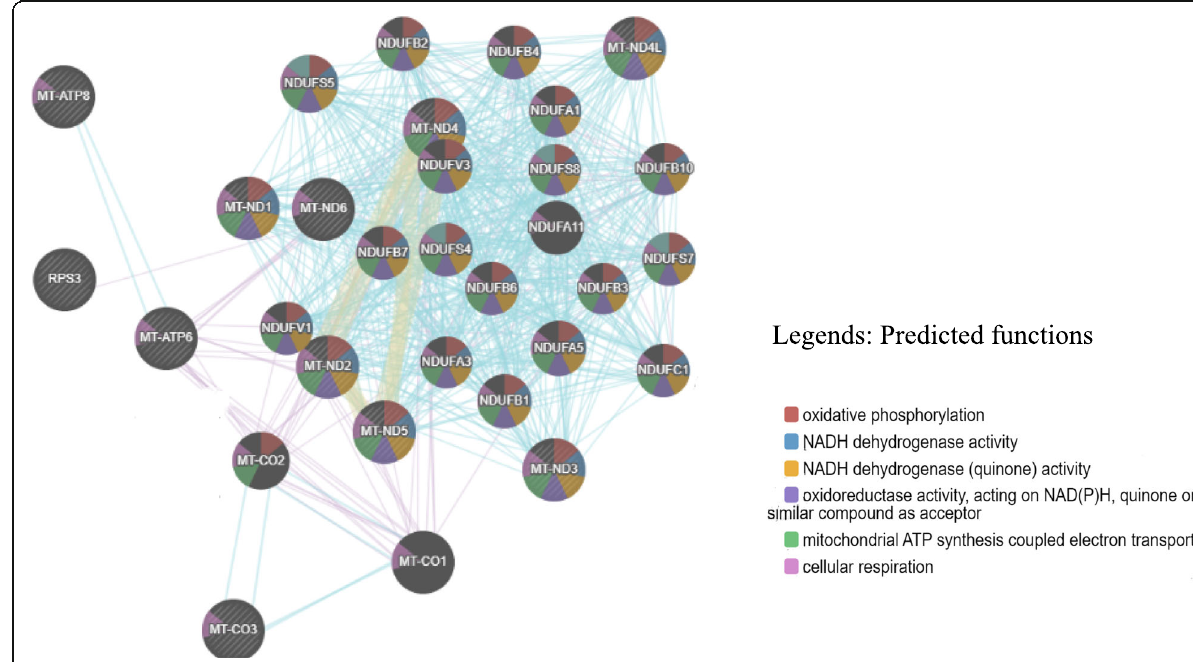
Fig. 4 Predicted functional interactions of mitogenome trn promoter region gene clusters by GSEA